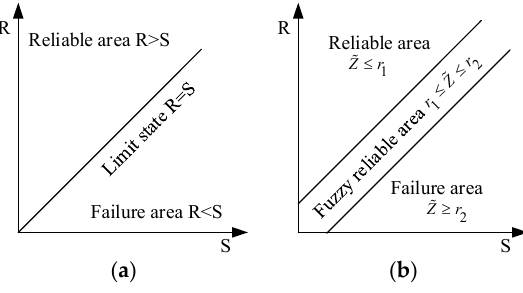
Figure 1. The working state of the structure in the theory of reliability. ( a ) Structural working state in traditional reliability theory; and ( b ) structural working state in fuzzy reliability theory.